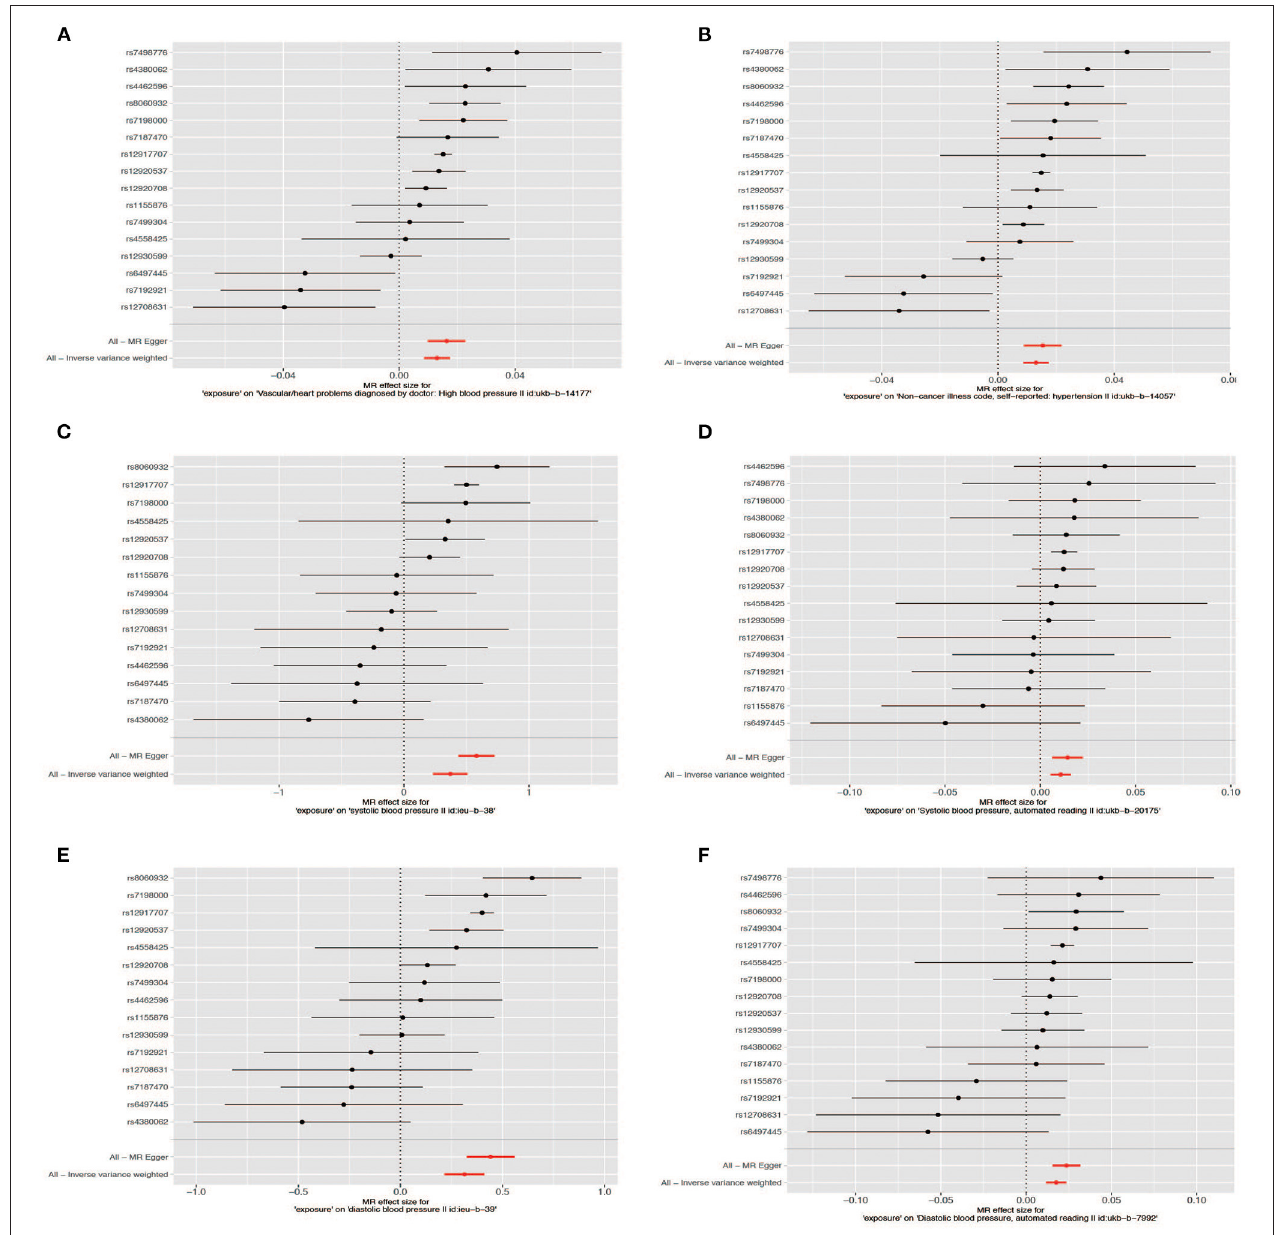
FIGURE 4 | Forest plot of the Mendelian randomization (MR) outcome. Hypertension: (A) (ukb-b-14177), (B) (ukb-b-14-57); systolic blood pressure: (C) (ieu-b-38), (D) (ukb-b-20175); diastolic blood pressure: (E) (ieu-b-39), (F)